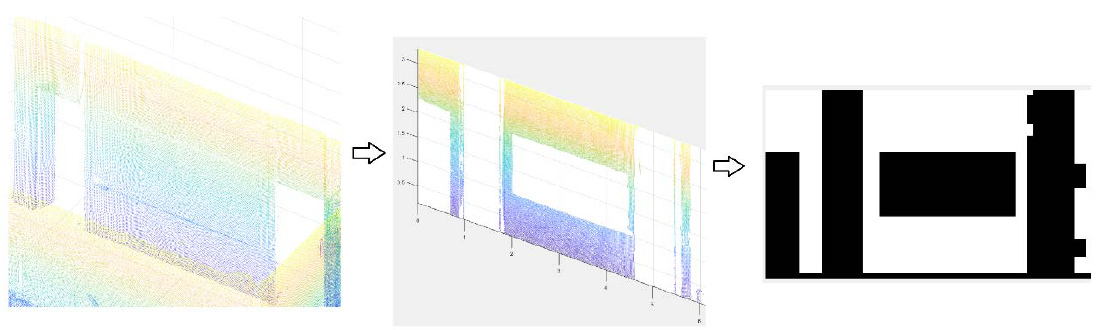
Figure 9. Blackboard occlusion shaped like a window (in meters).